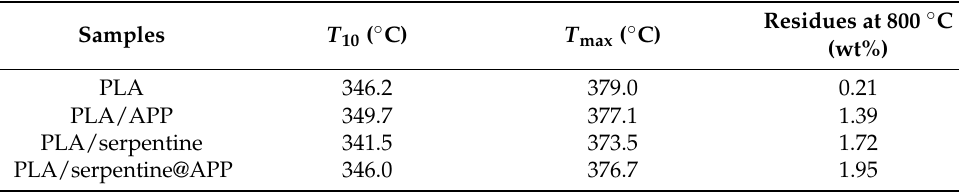
Figure 4. Thermal stability of pure PLA and its composites, ( a ) TGA, ( b ) DTG. Table 2. TGA data for pure PLA and its composites.